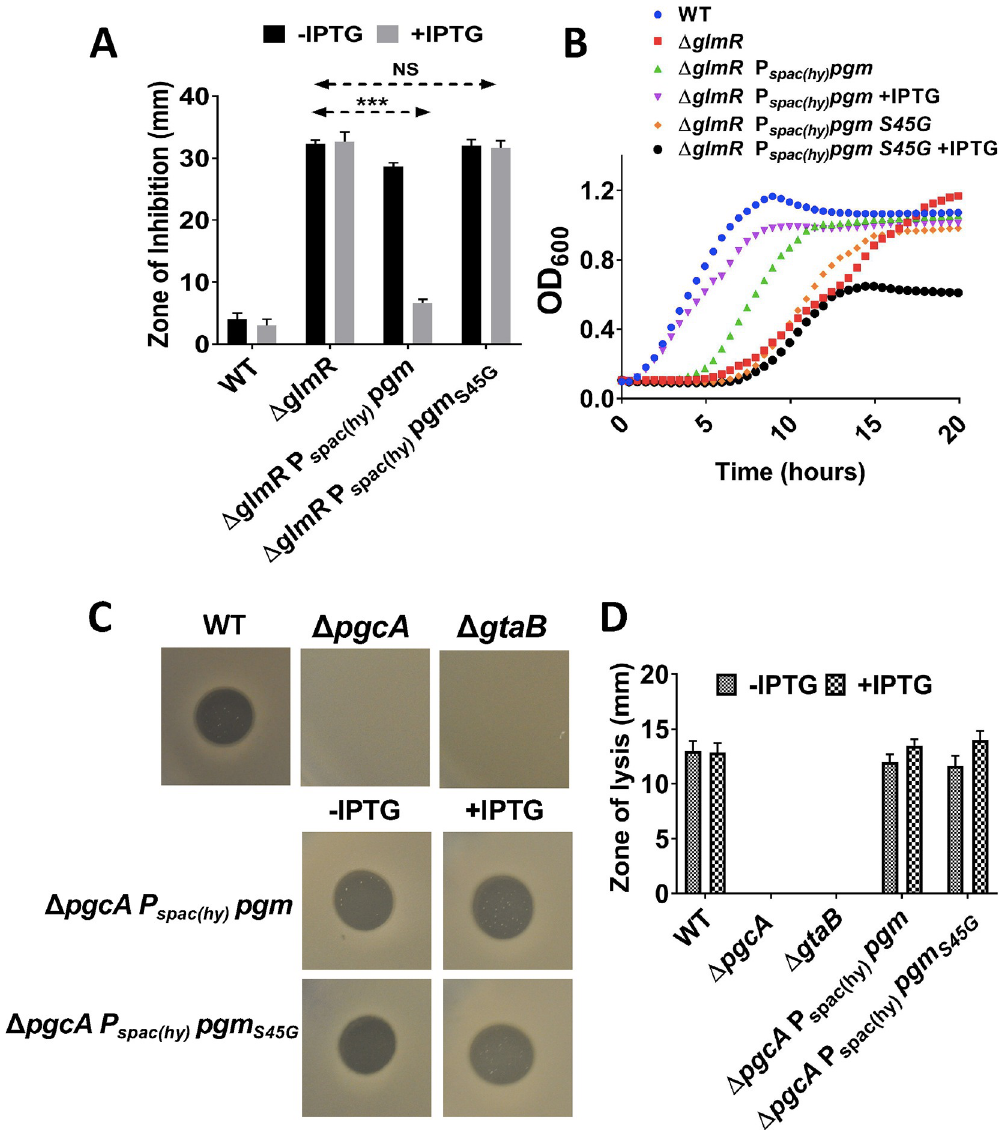
Fig 7. Escherichia coli phosphoglucomutase (Pgm) overexpression suppresses Δ glmR phenotypes in B . subtilis . (A) Bar graph showing CEF sensitivity assay. Three asterisks represent statistical significance with P < 0.001 with Tukey test. (B) Representative growth curve (N > 3) study in MH medium, (C) Images and (D) Bar graph showing SPP1 infection mediated zone of lysis. 10 μ l of 10 7 PFU/ml SPP1 was spotted on the lawns B . subtilis strains of interest. Cell lysis (plaque formation) was observed after overnight incubation at 37 0 C. Images are representative of at least three biological replicates, and error bars represent standard deviation.